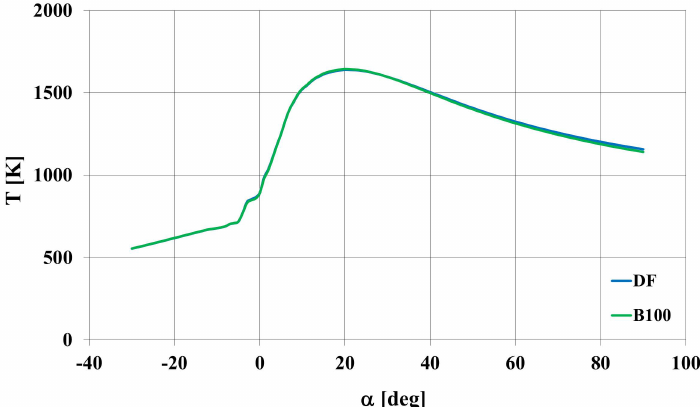
Figure 19. Process of the working factor temperature in the cylinder-T in the domain of the angle of rotation of the crankshaft- α at the rotation speed of 1600 min − 1 for the engine powered with fuels DF diesel or B100.